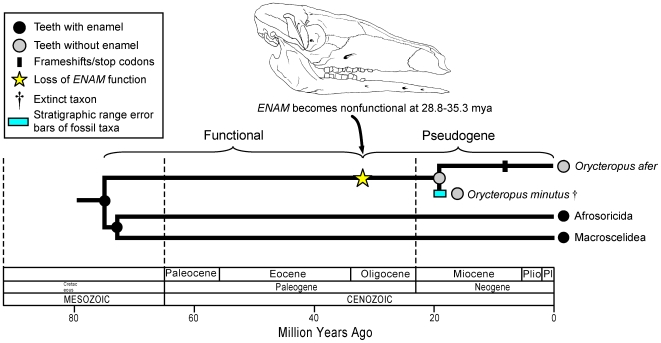
A synthetic interpretation of the history of enamel degeneration in Tubulidentata (aardvarks) based on fossils, phylogenetics, molecular clocks, frameshift mutations, and dN/dS ratios.Estimates for the timing of the transition from functional gene to pseudogene are based on decomposition of mixed dN/dS history into two distinct episodes of evolution under purifying selection and neutral evolution, respectively. The divergence time between Tubulidentata and Afrosoricida (golden moles, tenrecs) + Macroscelidea (elephant shrews) is from Murphy and Eizirik [23]. The age of the oldest aardvark, O. minutus, is from Milledge [25].